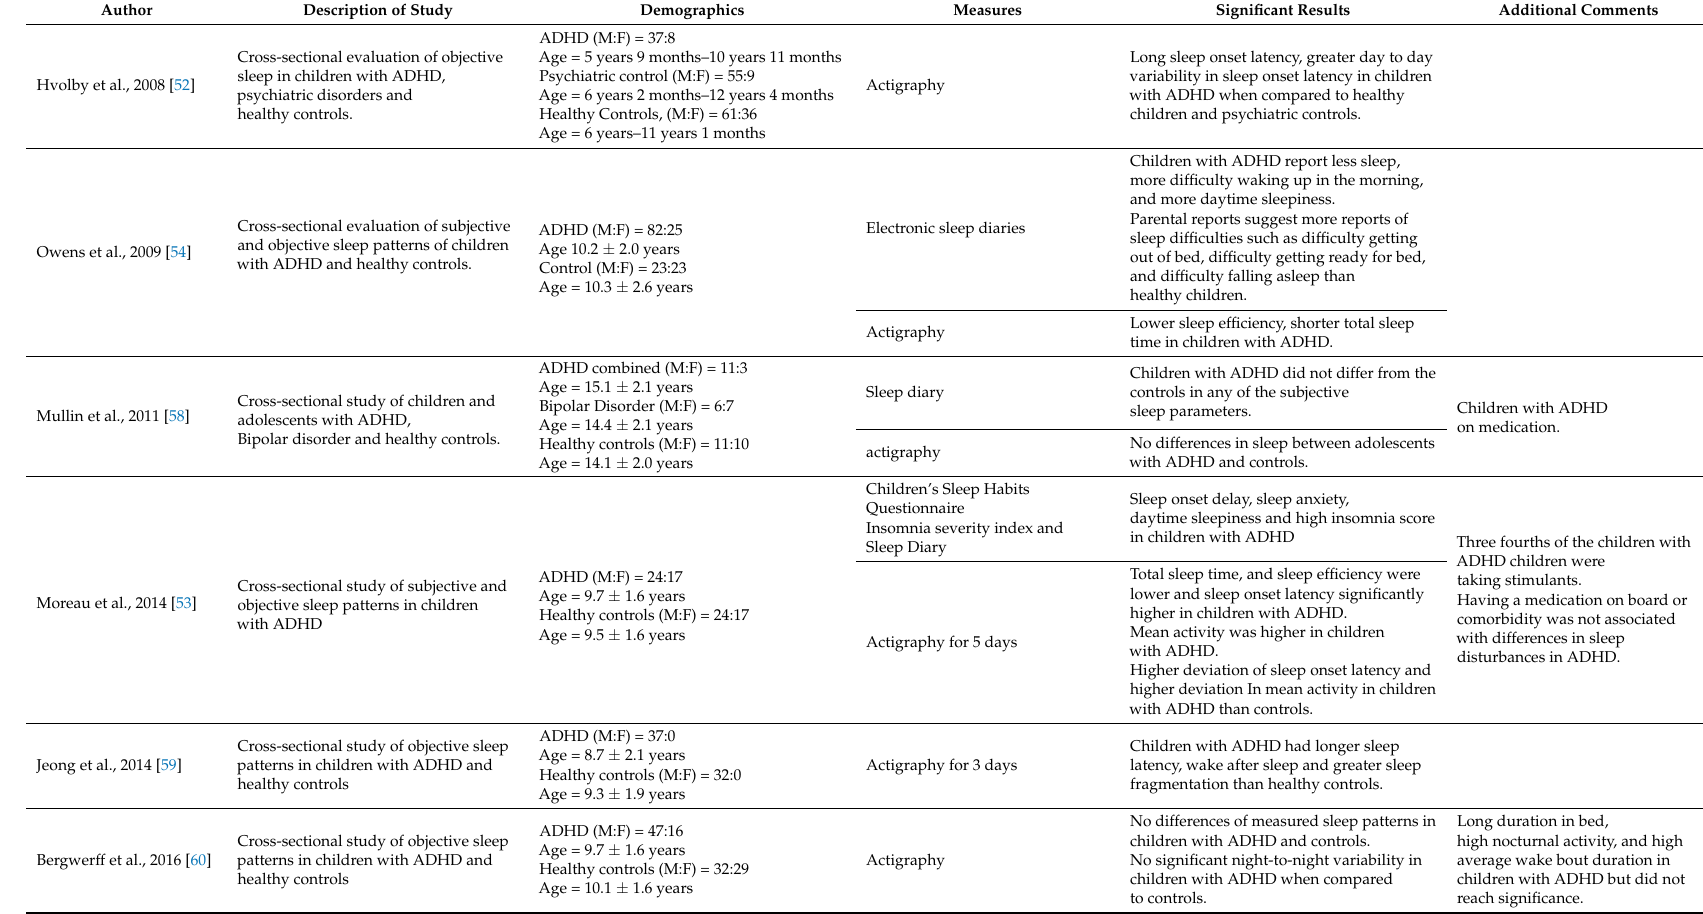
Table A2. Subjective and objective sleep parameters in attention deficit hyperactivity